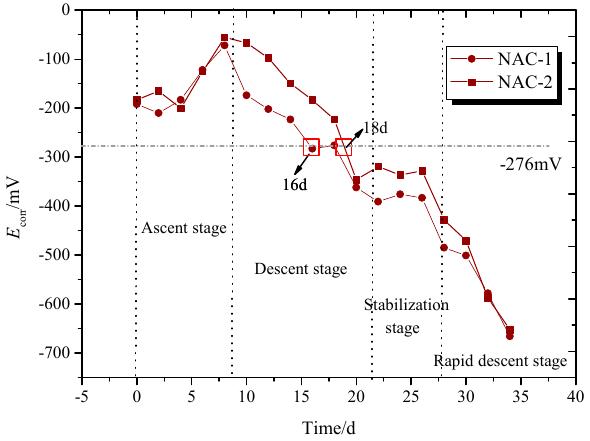
Figure 3. Time-varying curve of corrosion potential of reinforcement in NAC.